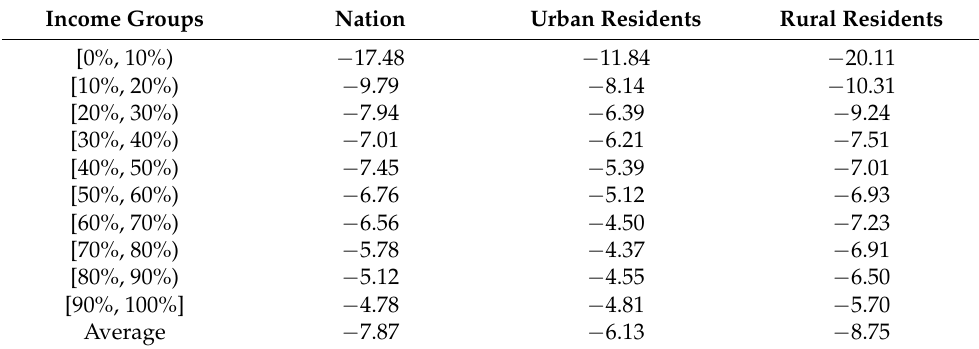
Table 2. Percentage changes in household per capita income of residents with different income levels (%).